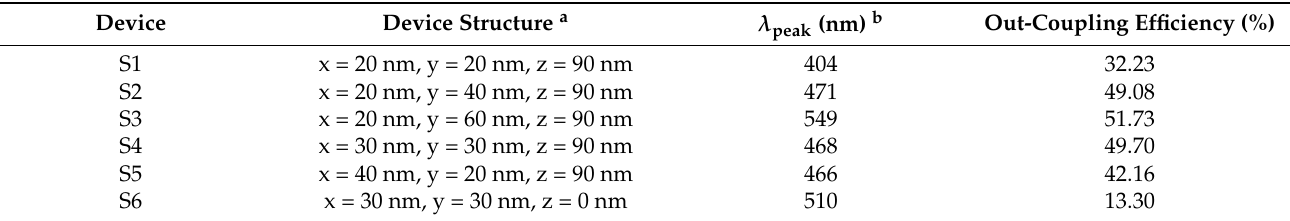
Table 1. FDTD simulation results of TOLEDs.